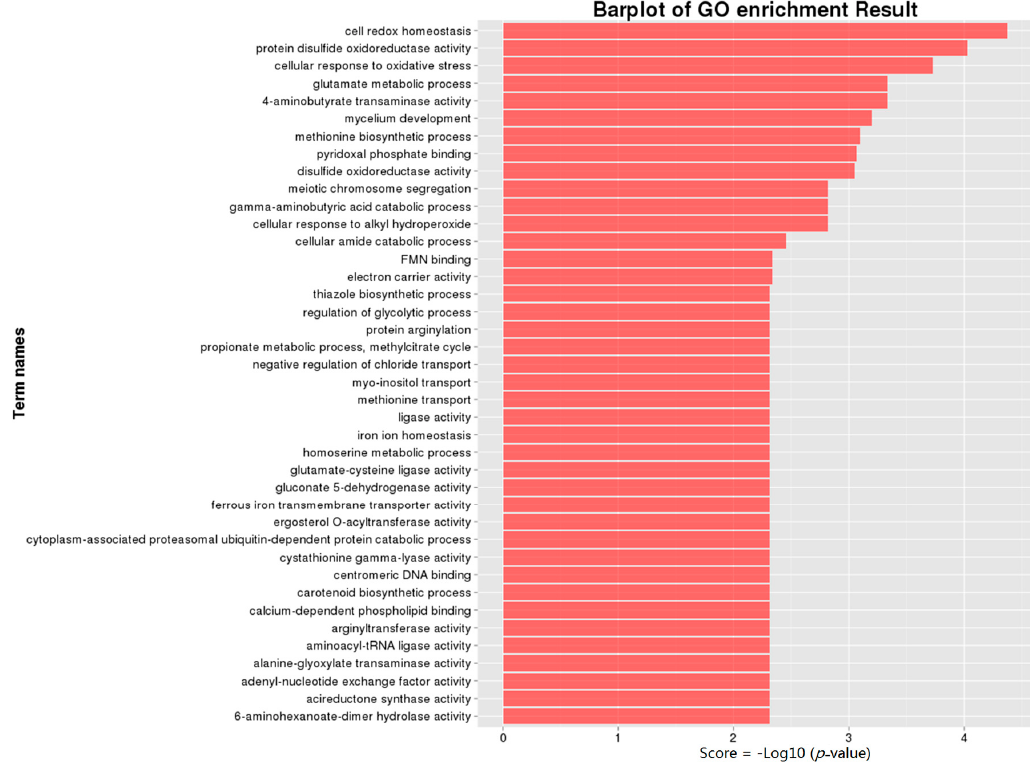
Figure 3. GO ontology classifications of differentially expressed genes. 305 DEGs were subjected to GO annotation. The vertical axis shows the names of clusters of GO terms, and the horizontal axis displays the − Log10 ( p -value). A p -value < 0.05 was used as a threshold to select significant GO terms.